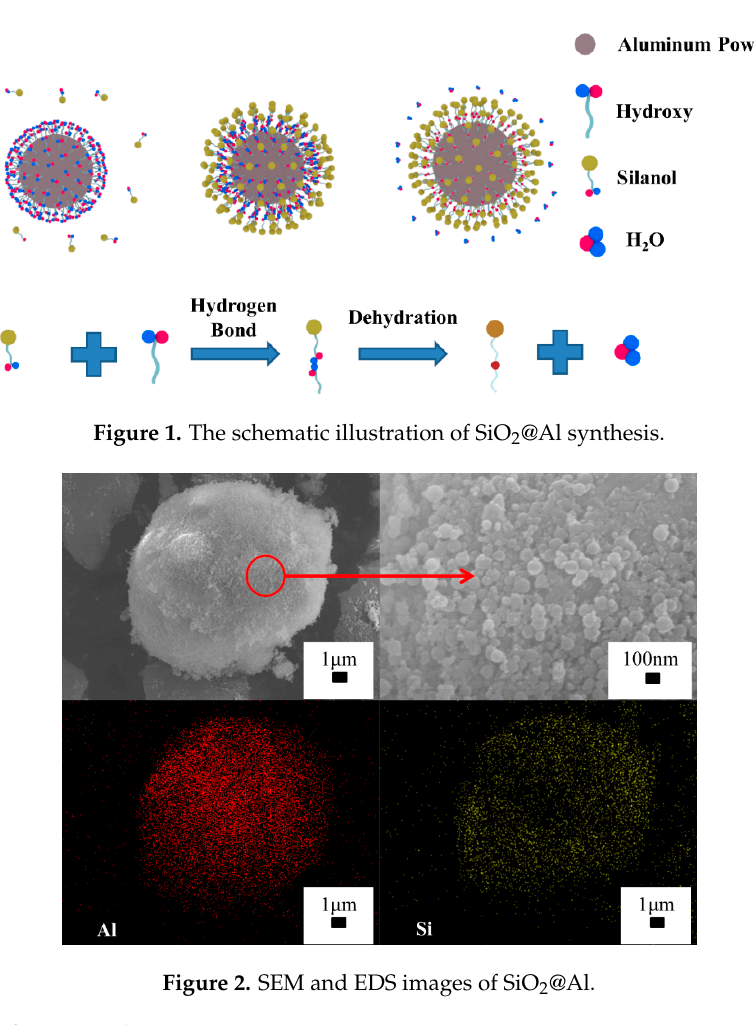
Figure 2. SEM and EDS images of SiO 2 @Al.